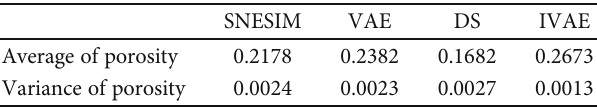
Table 2: Average and variance of the porosities of 20 reconstructed shale images using IVAE, SNESIM, VAE, and